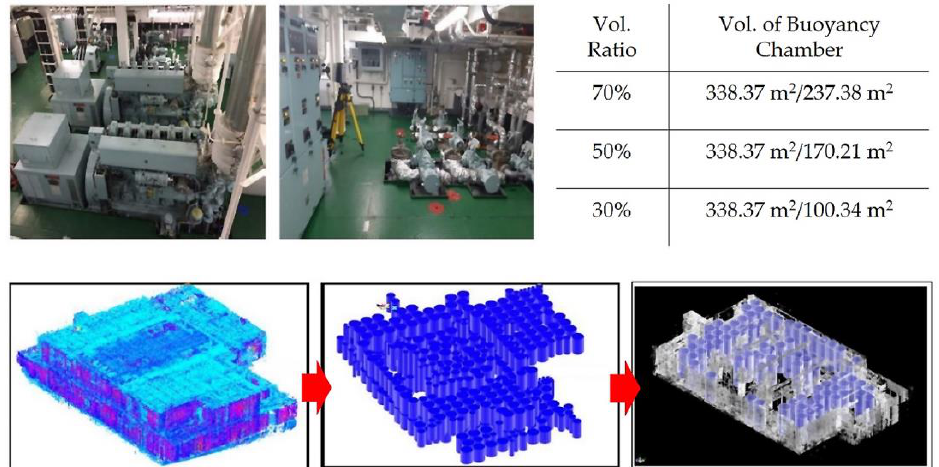
Figure 14. Case study result of 3D point cloud data basis buoyancy chamber arrangement in the machinery room.